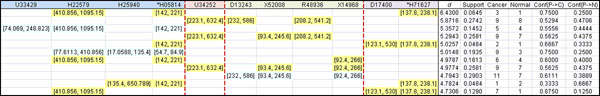
Top 10 patterns of colon cancer data set Different gene groups are filled in different colors and are separated by dashed lines. Patterns highlighted with yellow color indicate genes spanning across different gene groups while patterns highlighted with light blue color indicate genes in the same gene group. d is the adjusted residual. Conf(P->C) is the confidence that for a certain percentage of the samples containing the discovered pattern is cancerous. Conf(P->N) is the confidence that for a certain percentage of the samples containing the discovered pattern is normal. The gene marked with "*" indicates it is the mode of the gene group.